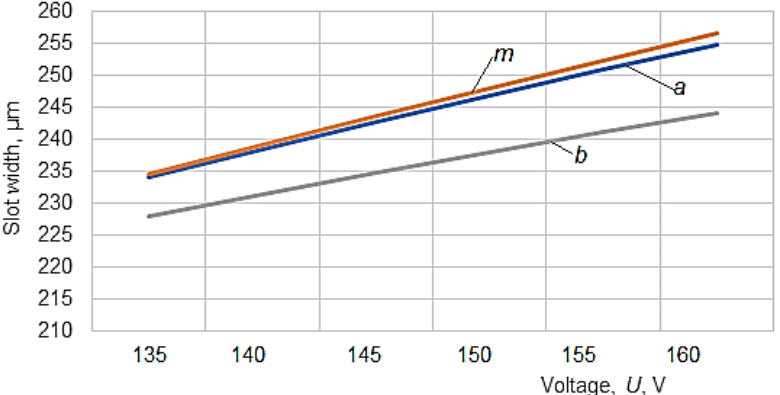
Figure 7. Influence of voltage U on the slot width entering the wire electrode in the test sample ( a ), in the middle of the thickness of the test sample ( m ), and at the exit of the wire electrode in the test sample (b), respectively ( H = 20 mm, T on = 12 µs, T off = 30 µs, I = 3.1 A, F = 10.54 N, v = 2500 mm/min).